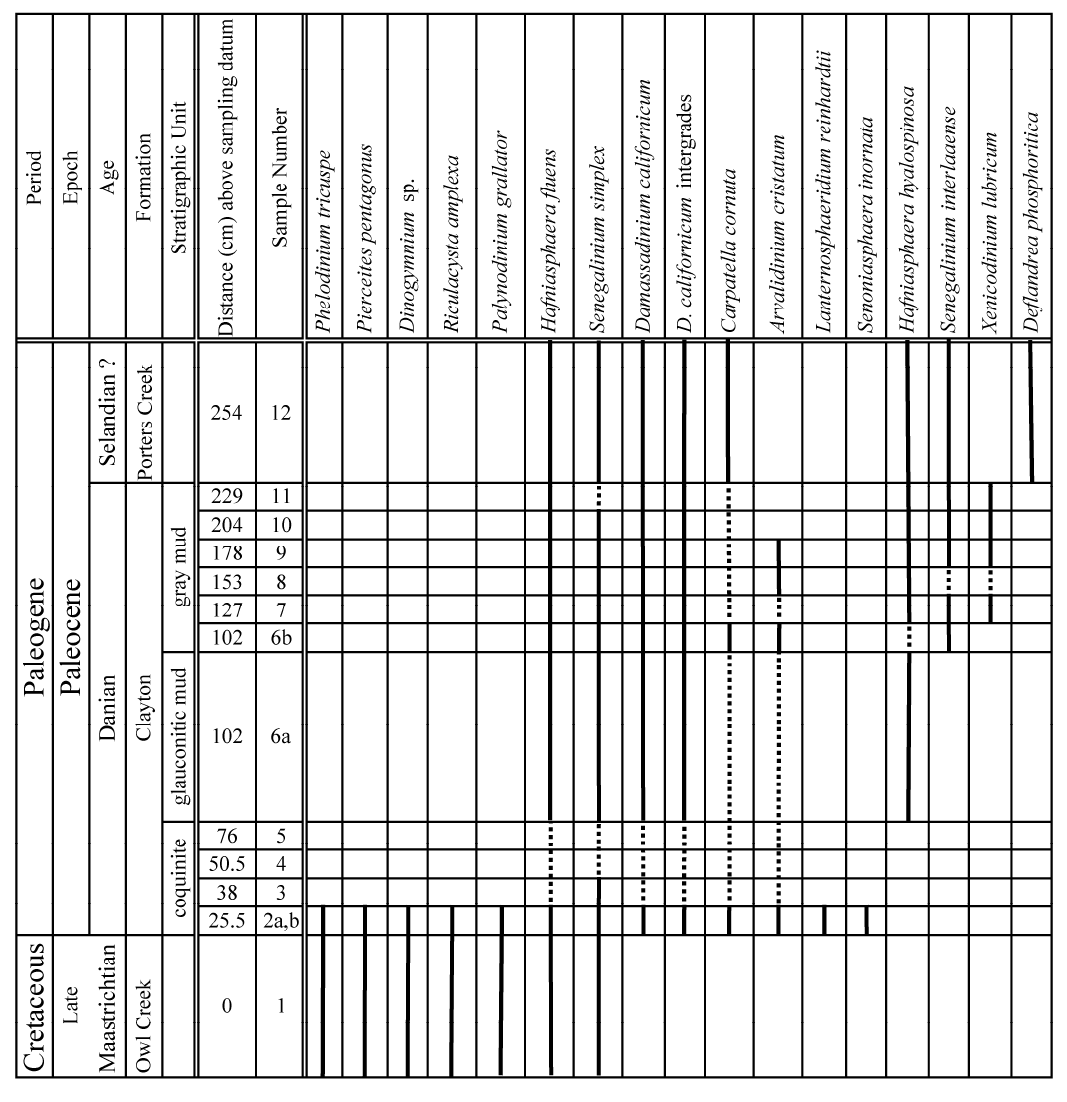
Figure 7. Stratigraphic ranges of 17 geochronologically significant (GS) dinoflagellate species in the Cretaceous-Paleogene sequence at Bloomfield, Missouri. Solid lines, species present in samples from the interval indicated at left. Dotted lines, species not present in samples from the interval indicated at